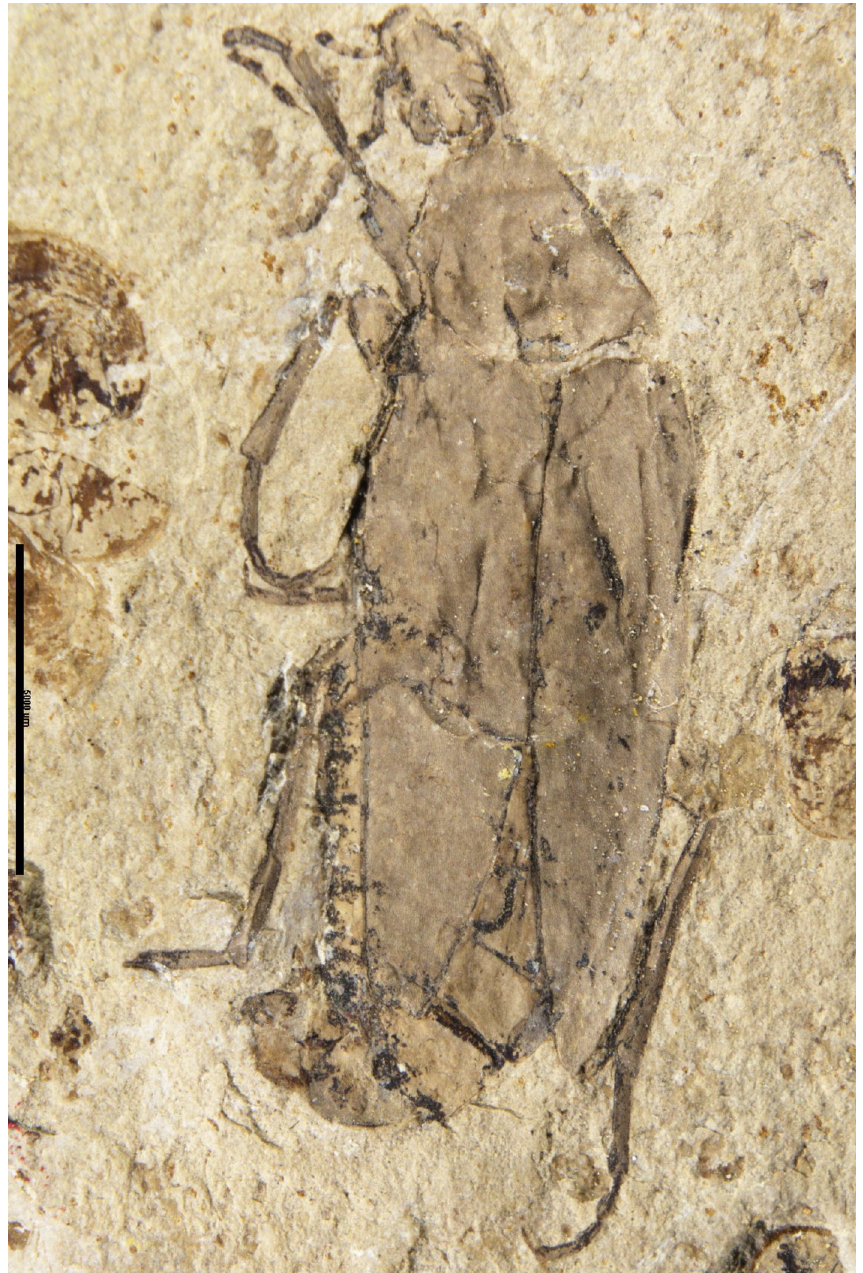
Fig. 1. Archaeoripiphorus nuwa Hsiao, Yu & Deng gen. et sp. nov., holotype, habitus, dorsal view. Scale bar = 5.0 mm. Photograph of dry